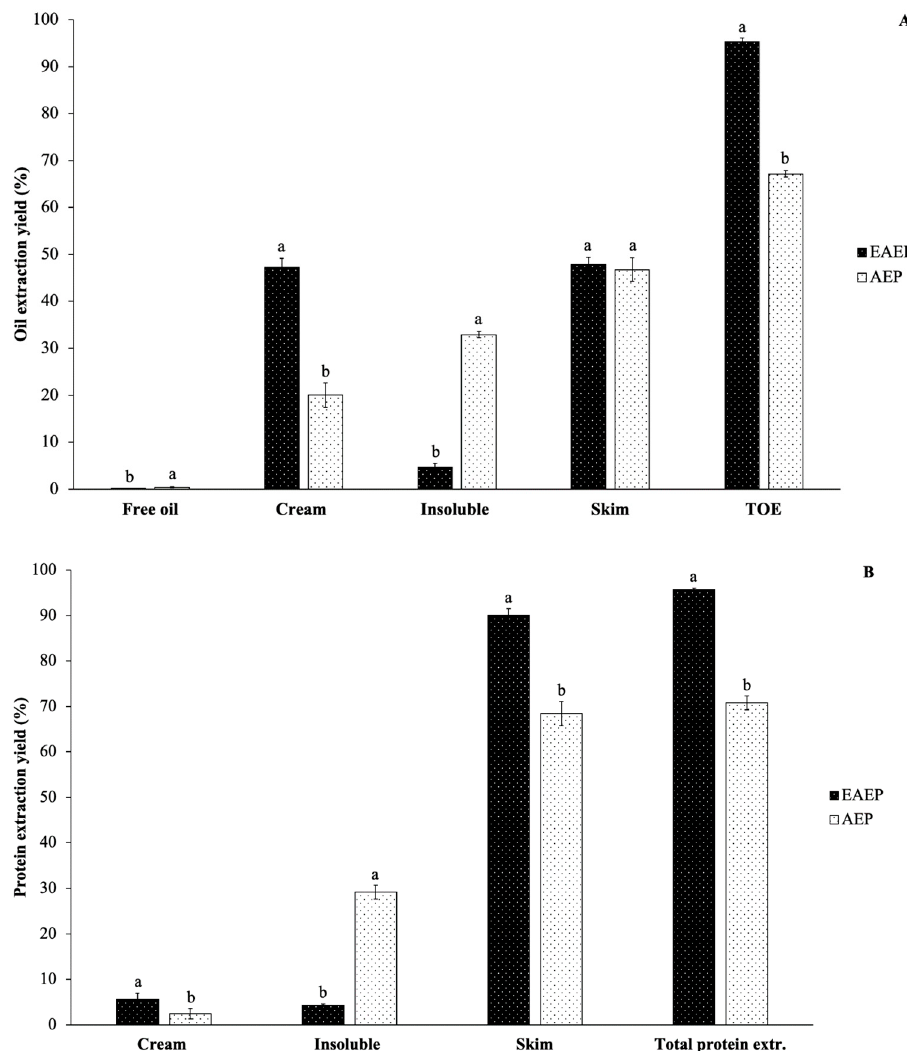
Figure 4. Oil ( A ) and protein ( B ) extraction yields and their distribution in the fractions. Different letters indicate statistically significant differences by one-way ANOVA followed by Tukey’s test at p < 0.05 .